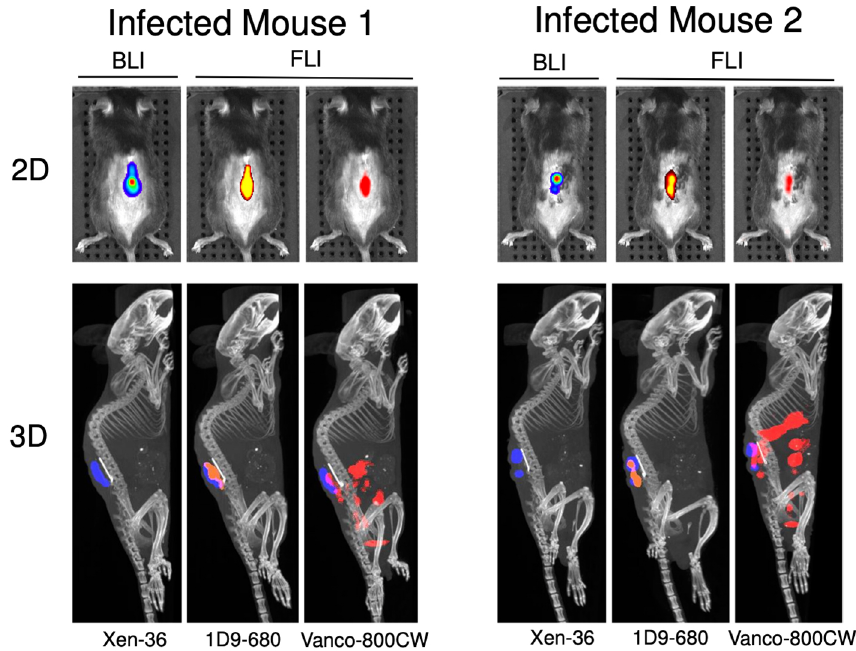
Figure 4. Three-dimensional bioluminescence and fluorescence imaging of spinal implant infection. At 72 h following PI, the mice were subjected to 3D-CT with bioluminescence and fluorescence imaging. Two representative infected mice are shown. The 1D9-680 probe signal colocalizes with the bioluminescent bacterial signal on the infected implant. The Vanco-800CW probe signal colocalizes with the infected implant, but is also detected in the pelvic and abdominal